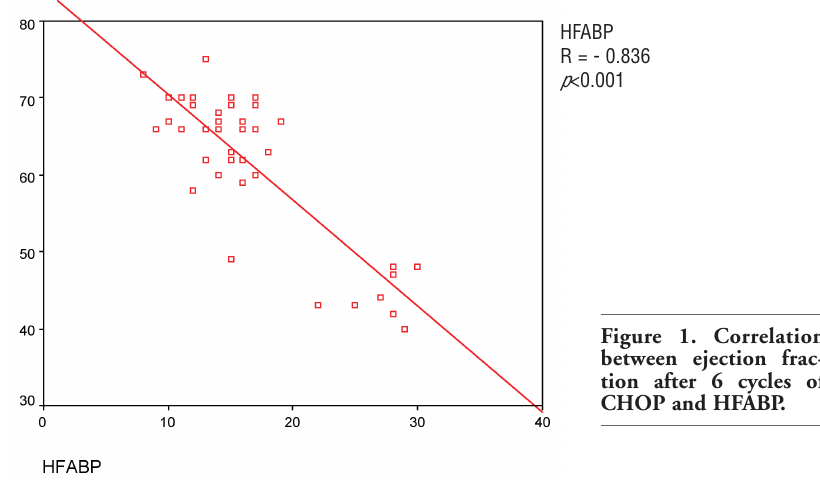
Figure 1. Correlation between ejection frac- tion after 6 cycles of CHOP and HFABP.